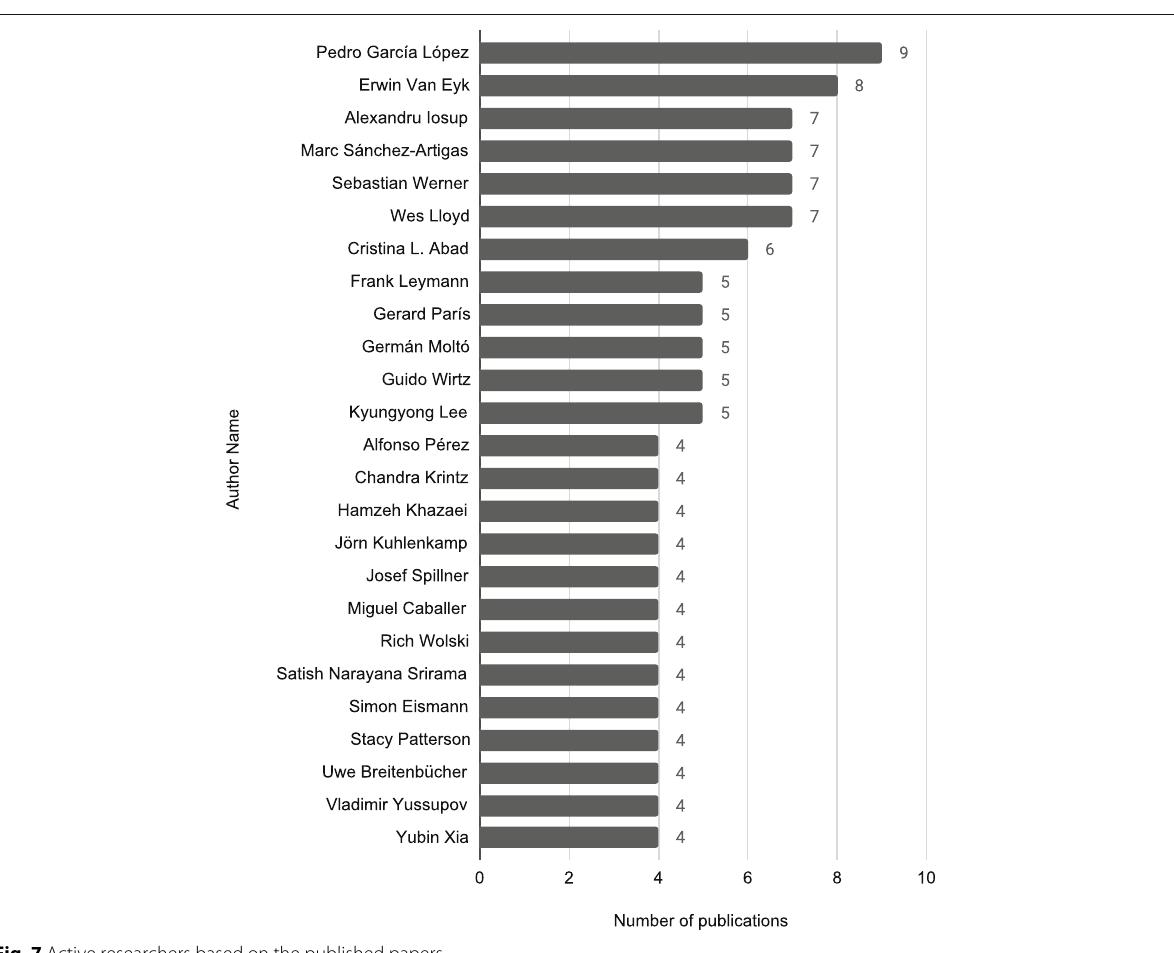
Serverless cloud providers take care of managing and maintaining the hardware and software required to deploy